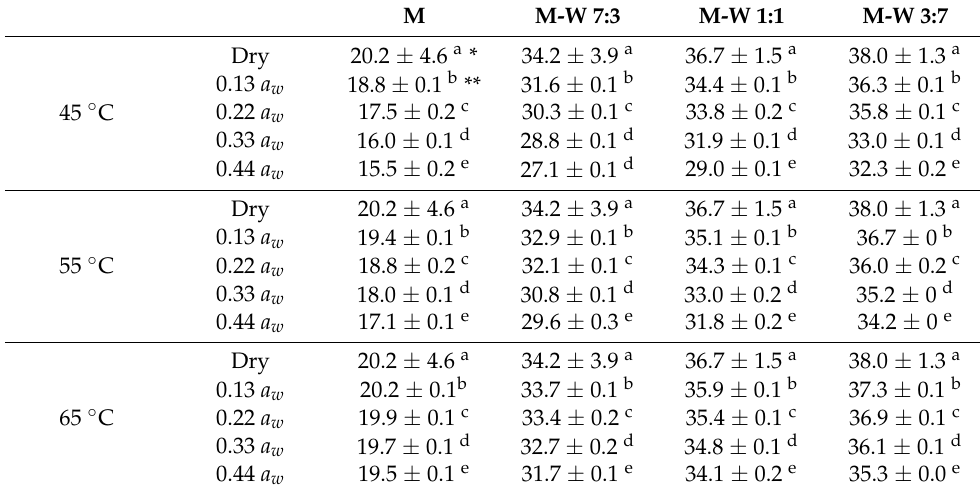
Table 3. The literature-derived S values for amorphous maltose (M) and maltose/WPI (M-W) mixture with all studied mass ratios at the studied conditions (dry state~0.44 a w and 45~65 ◦